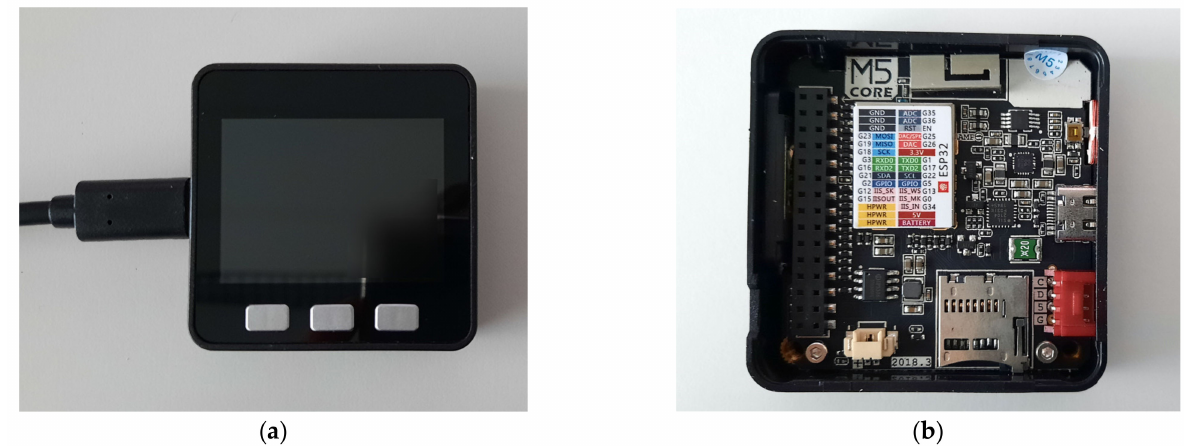
Figure 4. ( a ) M5 Stack Basic kit used for tests; ( b ) the kit opened, showing the